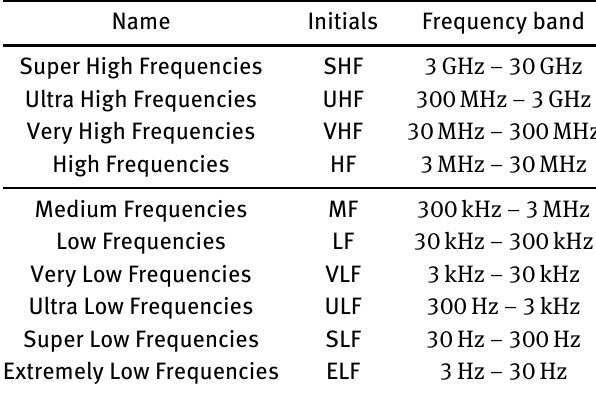
Table 5: Ranges of frequencies in which the theory in this paper can be applied.